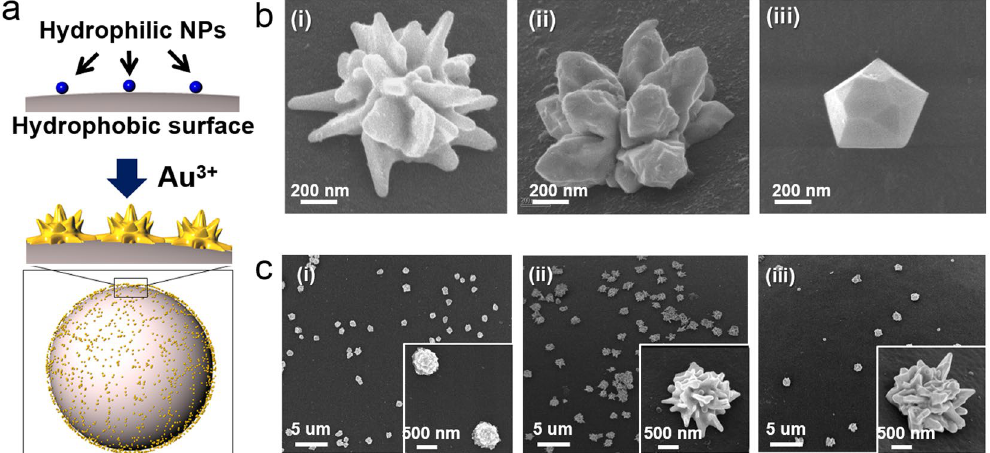
Figure 3. Gold NPs of various shapes and sizes immobilized on the beads. ( a ) Illustration of gold growth on the silica NPs. ( b ) SEM images of gold coated silica NPs on the beads (200 µ M) (i) in H 2 O solvent (stirring), (ii) in H 2 O solvent (shaking) (iii) in EtOH solvent, ( c ) SEM images of gold coated silica NPs on the beads (in H 2 O solvent) (i) 50 µ M, (ii) 200 µ M, (iii) 800 µ